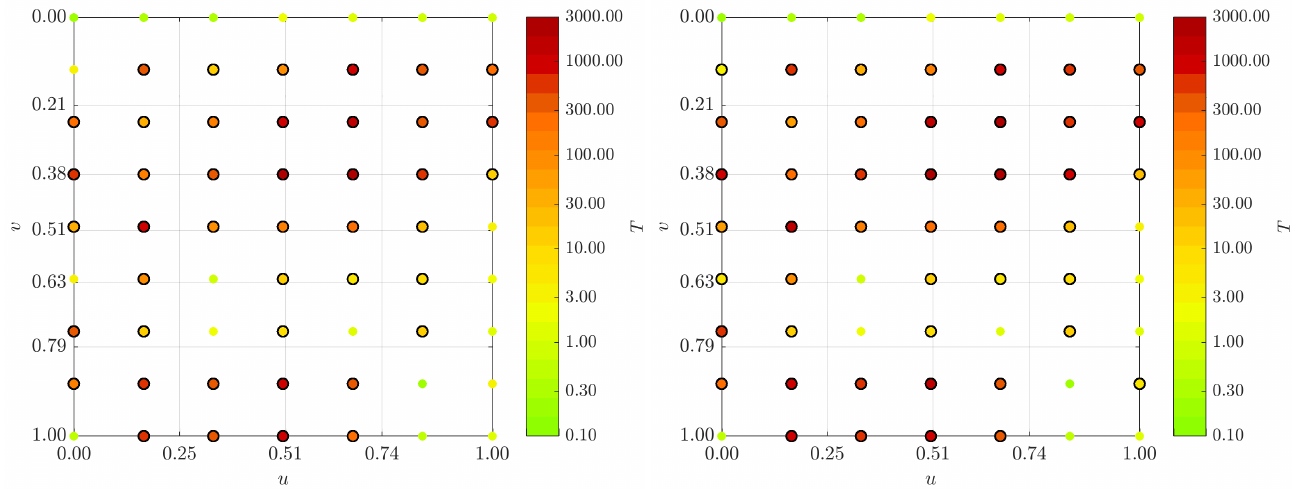
Figure A2. Test values T of the localisation procedure for data set V65 ( a = 0). For the circled points, the null hypothesis has to be rejected and, thus, these points are assumed to lie in the distorted region. Left: α = 1%, right: α =